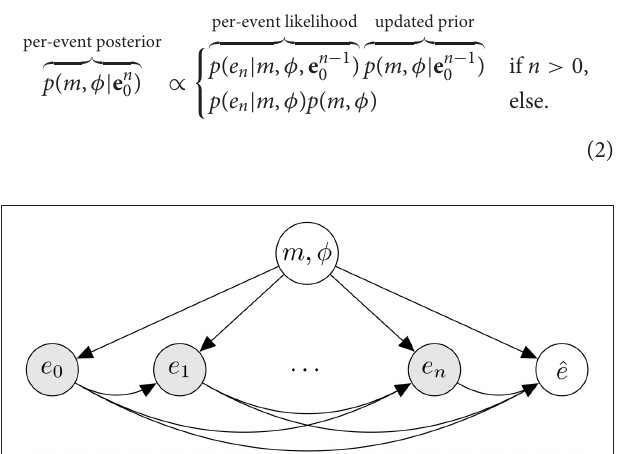
FIGURE 1 | Conditional dependency relations assumed by the model between its probabilistic variables visualized as a graphical model (Bishop, 2007, ch. 8). Shaded nodes represent observed variables, unshaded nodes represent unobserved, hidden variables. Each node in the graph is associated with a discrete probability distribution. If one or more arrows terminate at a node, its associated probability distribution is conditioned on the node(s) that the arrows originate from. Nodes labeled e n represent musical events indexed by n . The hidden variable at the top represents a metrical interpretation. The hidden variable labeled ˆ e represents a predicted subsequent